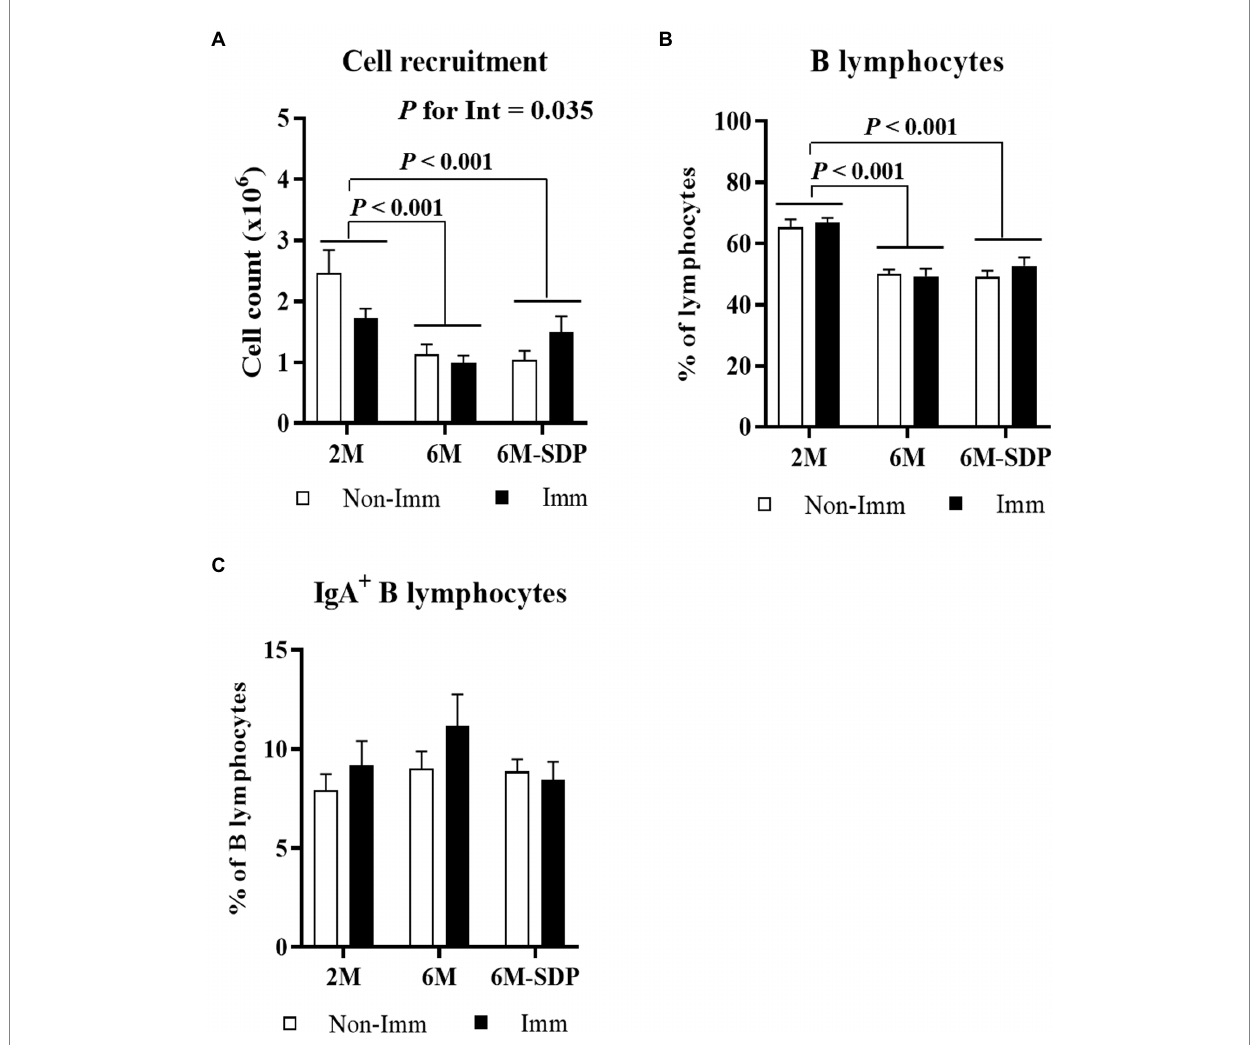
FIGURE 3 Cell recruitment (A) , percentage of B lymphocytes (B) , and percentage of IgA + B lymphocytes (C) in Peyer’s patches. Open bars represent non- immunized mice ( Non-Imm ); solid bars represent immunized mice ( Imm ). Results are expressed as means ± SEMs ( n = 9–10 animals). Statistics: two- way ANOVA (age-feed and immunization factors; Fisher multiple comparison test). Int indicates the interaction between immunization and age-feed factors. IgA, immunoglobulin A; SDP, spray-dried porcine